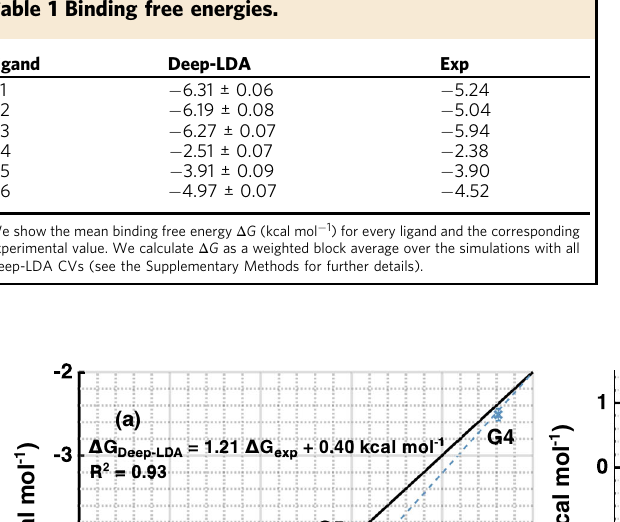
Fig. 3 Free energy surfaces projected along the host – guest distance. For each of the six ligands, we compute the free energy along the s z variable using a standard umbrella-sampling-like reweighting formula to recover the unbiased distribution 13 . The shaded areas indicate the errors, whose calculation is detailed in the Supplementary Methods. To ensure that the results do not depend on a speci fi c realisation of the Deep-LDA CV, we repeat the training three times by using different initial weights of the NN. The resulting CVs are denoted as s a , s b , s c , and the corresponding FES are w w w indicated, respectively, by dashed, dotted, and dash-dotted lines. For clarity, curves related to the same ligand but with different CVs are shifted by 1 kcal mol − 1 , while the shift between different ligand curves is 5 kcal mol − 1 . Table 1 Binding free energies.